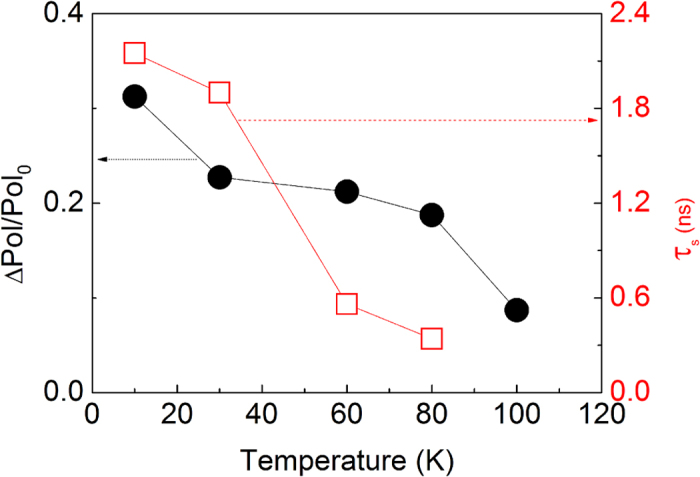
Temperature dependence of the spin relaxation time (τs) (open squares) and the ratio (ΔPol/Pol0) obtained using Δt = 0.6 ns (solid circles) for sample MN1.